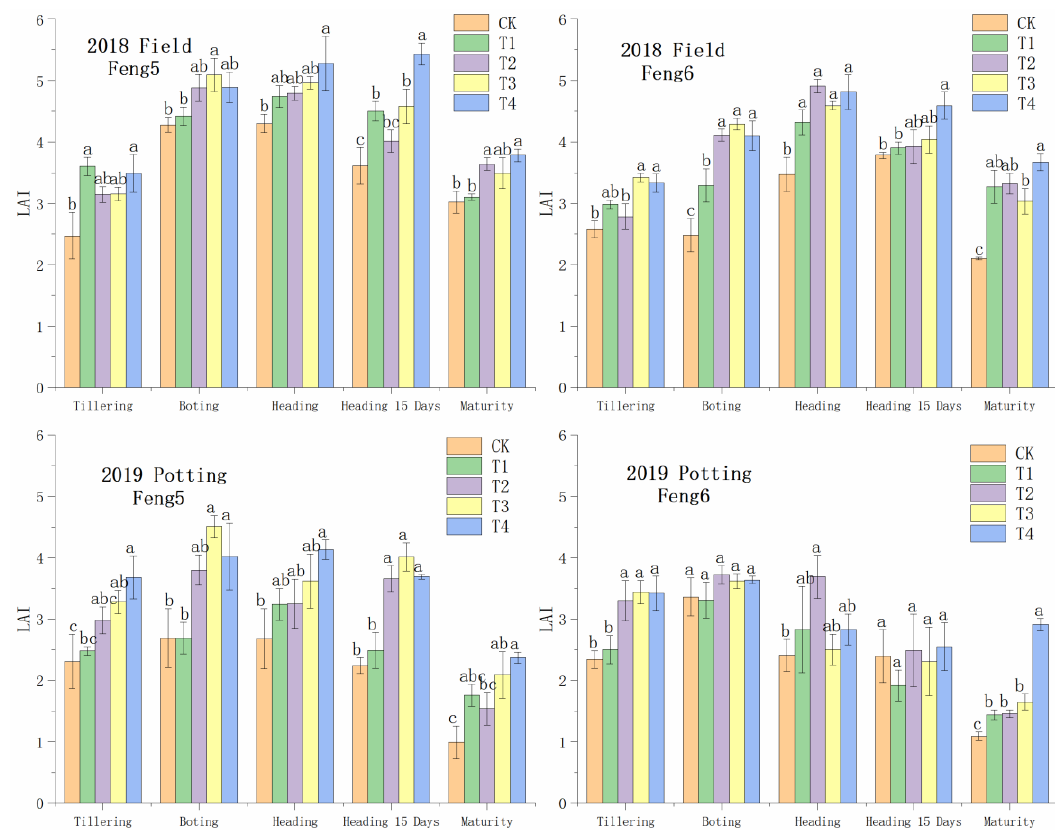
Figure 2. The leaf area index of giant rice under different treatments. Different small letters mean significant at p < 0.05 level within a variety.